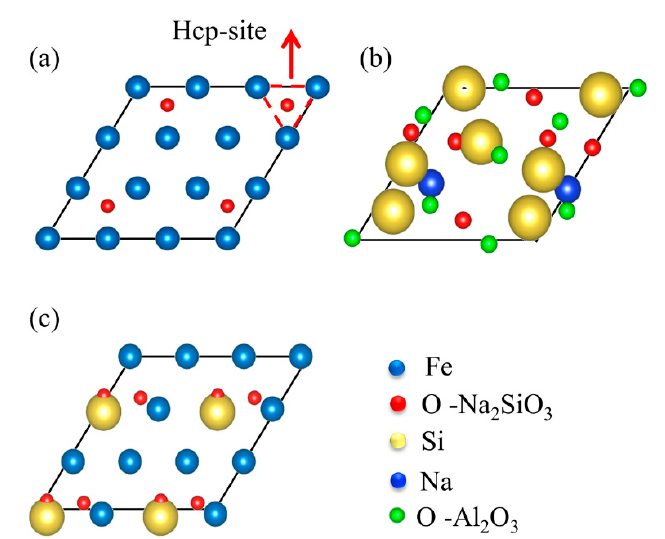
Figure 3. Three kinds of stacking sequences for the O-terminated Fe-amorphous Na 2 SiO 3 -Al 2 O 3 and Fe-Al 2 O 3 interfaces: ( a ) hcp, ( b ) hole, and ( c ) top.